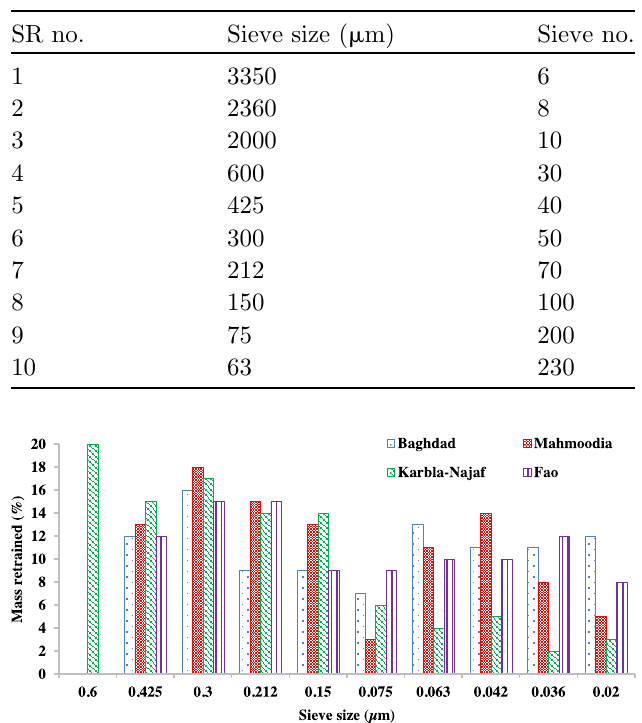
Table 1. The used sieves sizes.